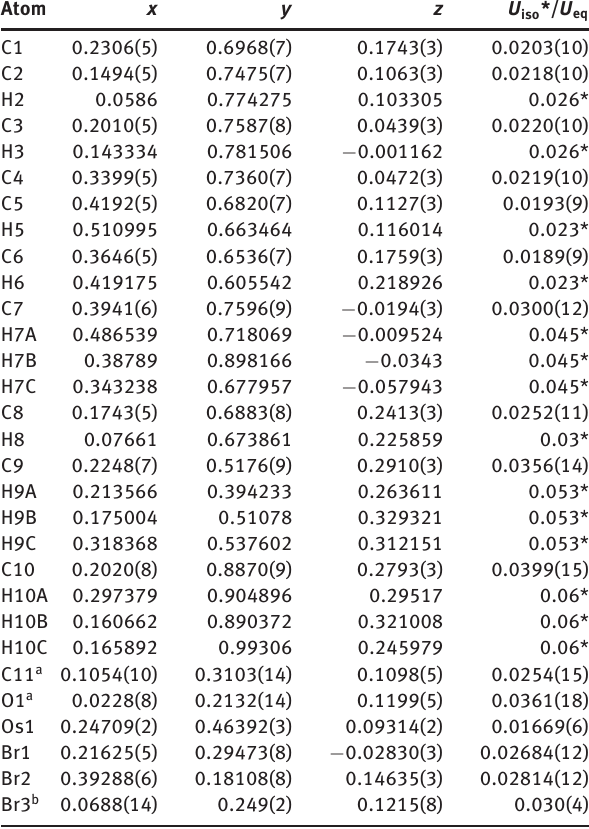
The p -cymene ring is slightly puckered with Os—C dis- tances in the range 2.200(6)–2.335(6) Å. The distance from the ring centroid to the Os centre is calculated to be 1.74